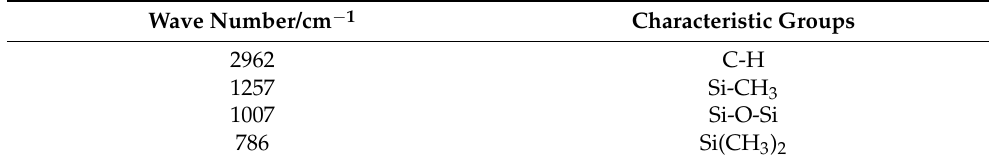
Table 3. Characteristic groups of